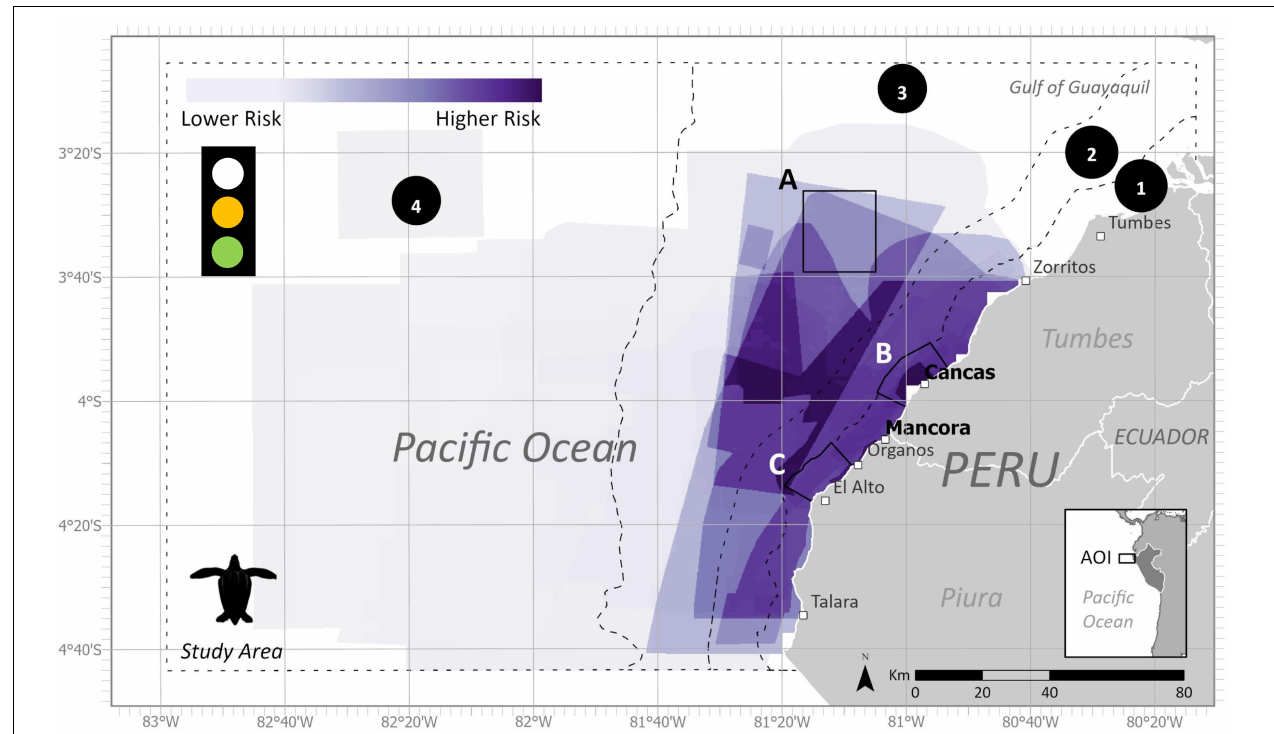
FIGURE 9 | Final estimated bycatch risk within the study area and subzones for leatherback turtles during the austral summer (December-May) with all fishing polygons. (1) Artisanal fishing zone (5 nm), (2) Territorial seas zone (12 nm), (3) Shelf zone, (4) Beyond shelf zone, (A) Banco de Mancora, (B) Arrecifes de Punta Sal, and (C) Cabo Blanco–El Ñuro. Data uncertainty depicted in stoplight and described further in Table 3